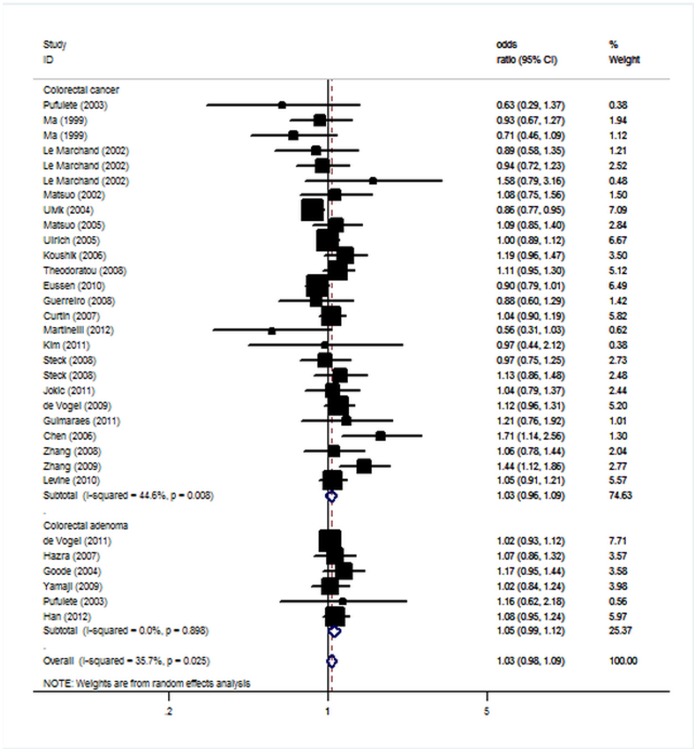
Forest plot from the meta-analysis of MTR A2756G polymorphism and CRC/CRA risk.